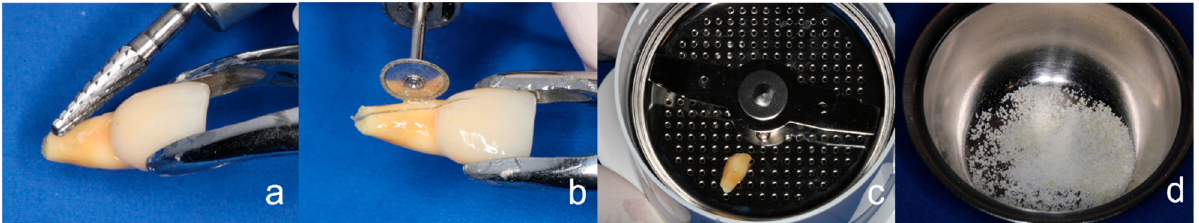
Table 1. Starting characteristics of treated patients in augmentation with autogenous dentin.